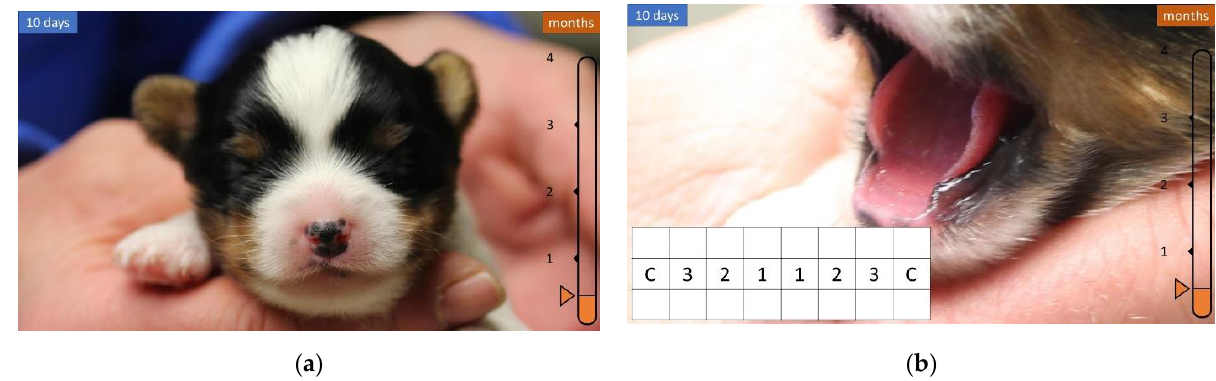
Figure 2. Development of the head and teeth in the first 10 days of life. (a) Near-spherical skull. (b) There are no teeth.